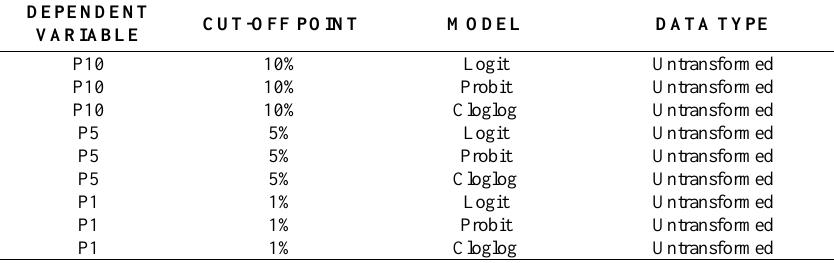
Table 8. The best combinations of the state of turbulence models assumptions.